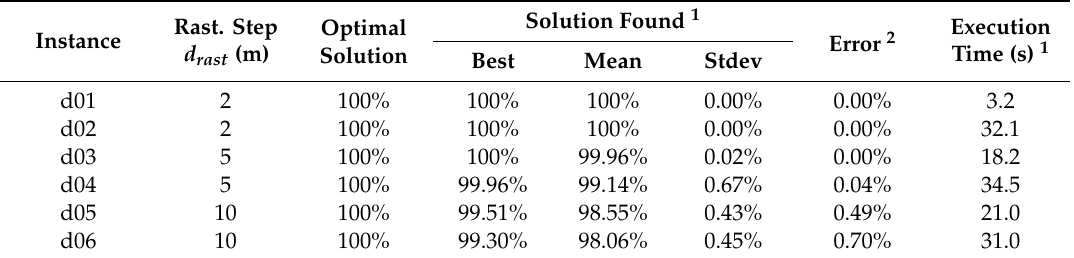
Table 5. Results for benchmark problems achieved by the discrete version of the algorithm.